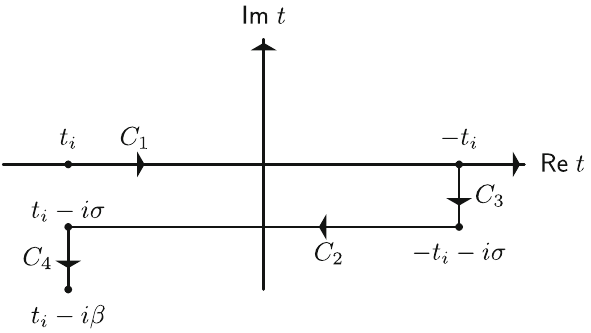
Fig. 2 Standard time path for real time formulation of thermal field theories. The type-1 and type-2 thermal fields “live” on the C 1 and C 2 paths of the